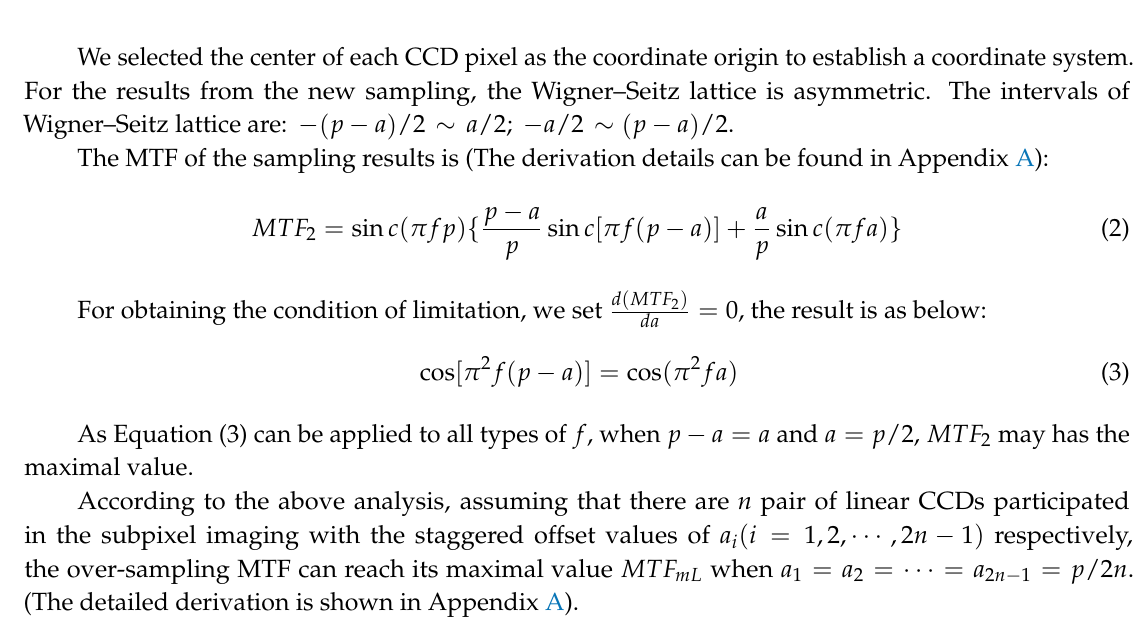
Figure 4. Sampling results of linear CCD pair. ( a ) Sampling of the first linear CCD; ( b ) Sampling of the second linear CCD; ( c ) Sampling results of the first linear CCD and the second linear CCD.